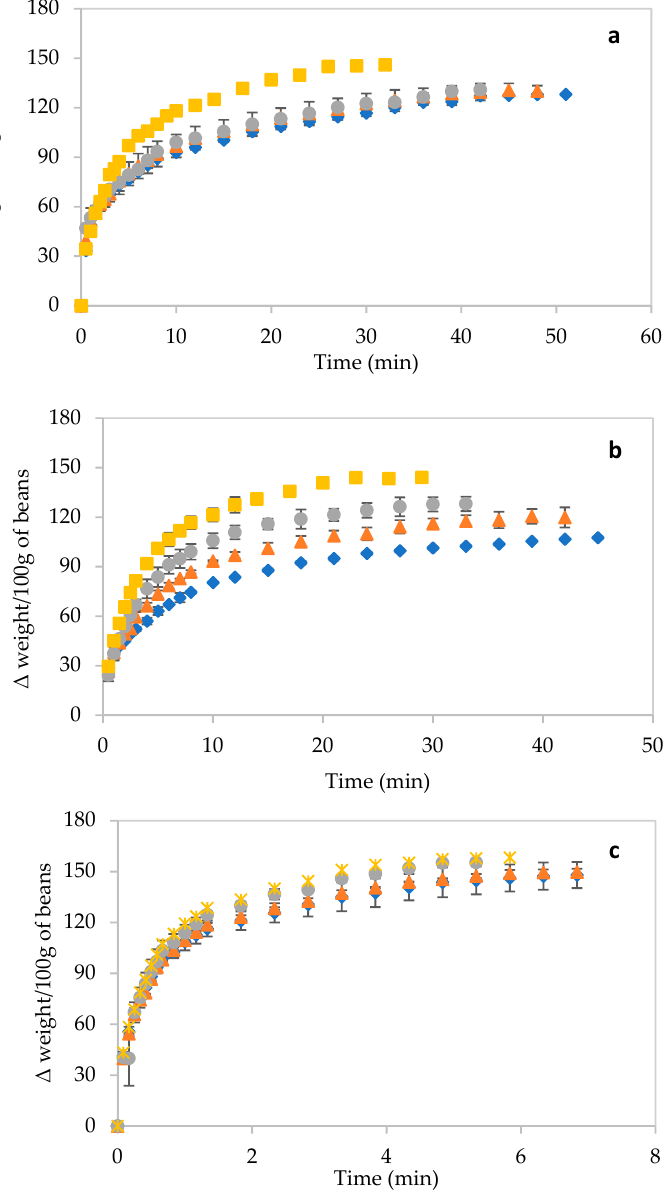
Figure 2. Rehydration profiles of air-dried ( a ), vacuum-dried ( b ) and freeze-dried ( c ) beans at 70 °C ( ⬥ ), 80 °C ( ▲ ), 90 °C ( ● ) and 100 °C ( ■ ). Irrespective of the temperature of the rehydration medium, rehydration was faster in the initial phase of the process and then slowed down, finally reaching an equilibrium. Some leaching of the solutes might also occur simultaneously. The rehydration of FD beans was 9–10 times faster than that of AD and VD beans, which exhibited almost similar rehydration times. This difference in the rehydration rate is attributed to differences in the porosity of the structures obtained after drying. Freeze drying leads to the creation of multiple interconnected open pores, while in contrast, the lower rehydration rate in AD and VD samples manifests in closed or blind pores. Together with their dense and shrunken structure, this results in lower rehydration rates. Increasing the rehydration temperature resulted in a higher rehydration ability (related to Y and RRM), with a decreased rehydration time. This effect was prominent in vacuum-dried beans, but also,